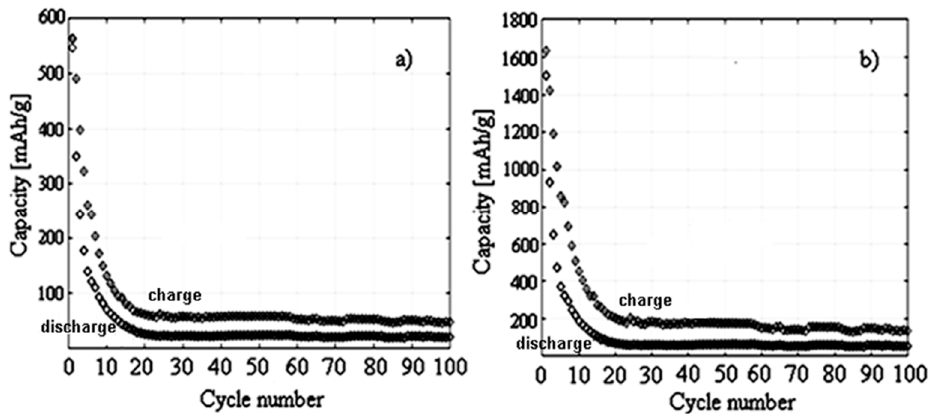
Figure 11. Trend as a function of cycle number ( a ) CS, ( b ) SDR.